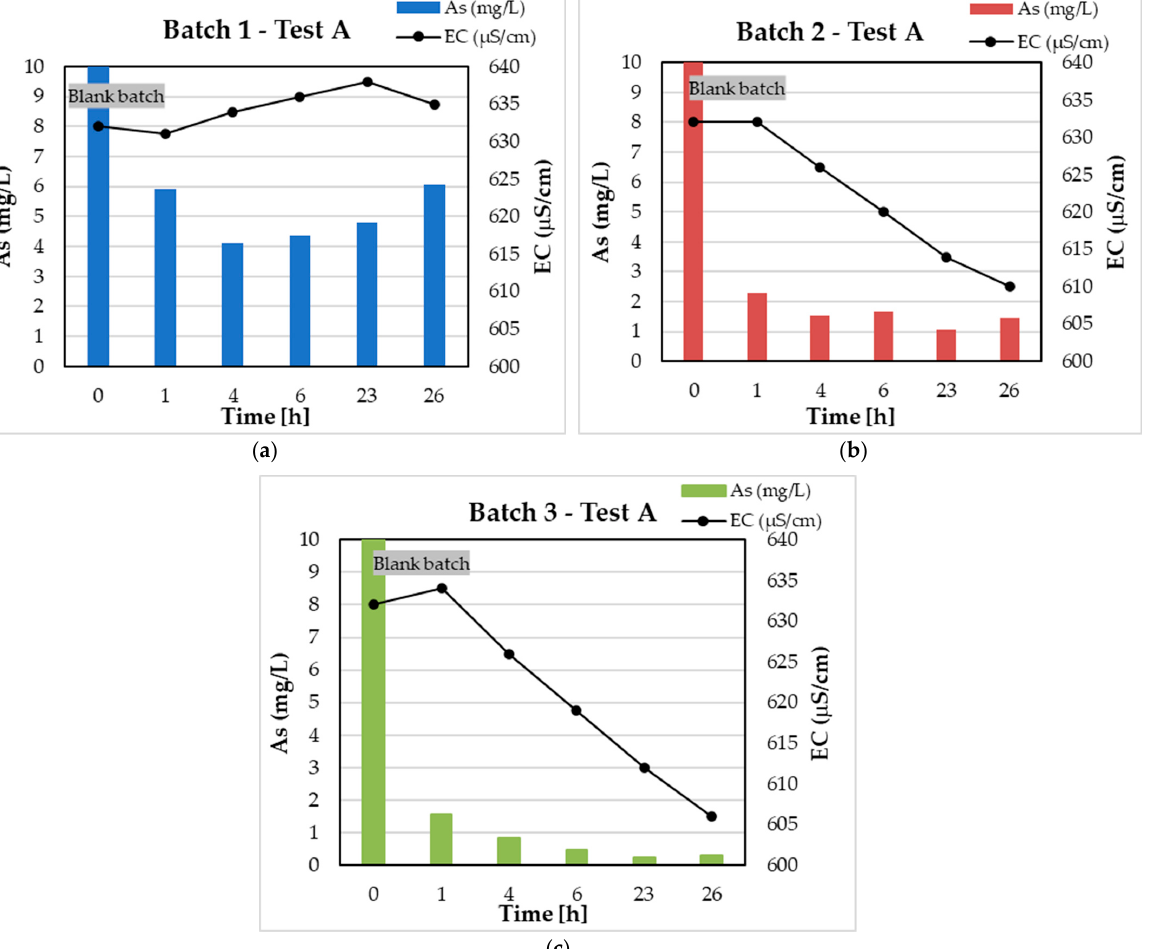
Figure 5. As – and EC trend (Test A): ( a ) Batch 1, ( b ) Batch 2 and ( c ) Batch 3 . Figure 5. As and EC trend (Test A): ( a ) Batch 1, ( b ) Batch 2 and ( c ) Batch